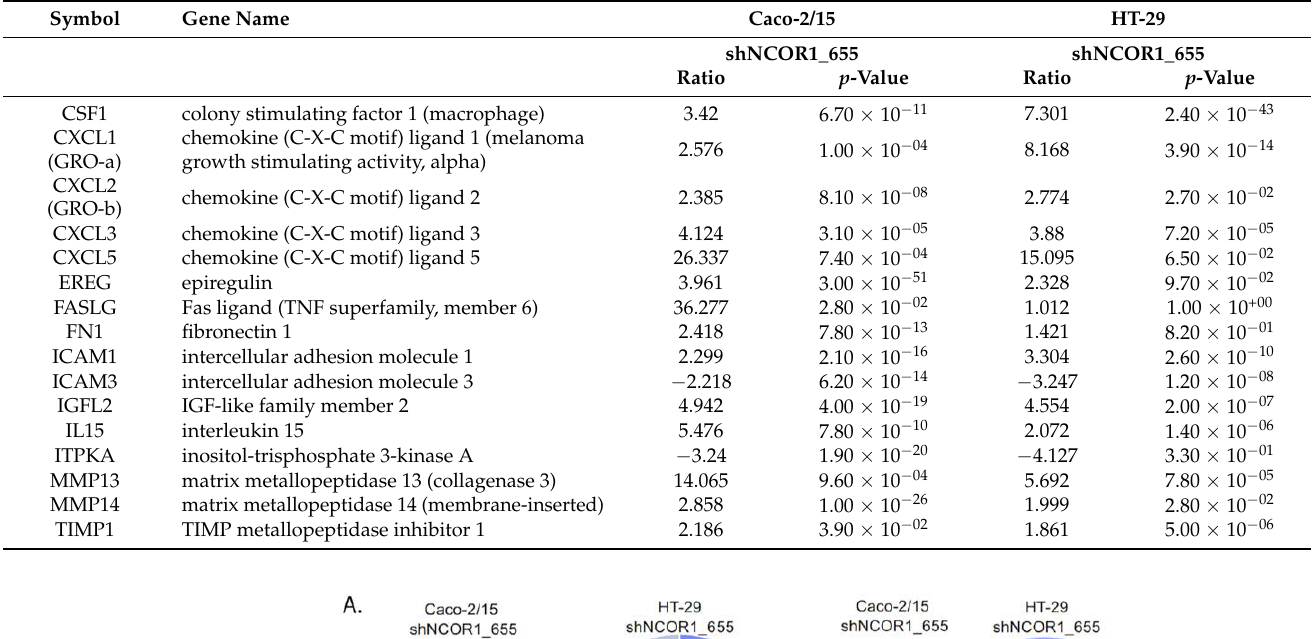
Table 2. List of genes associated with SASP and significantly modulated (change ratio of >2; p < 0.05) in both Caco-2/15 and HT-29 cells depleted for NCOR1 expression.